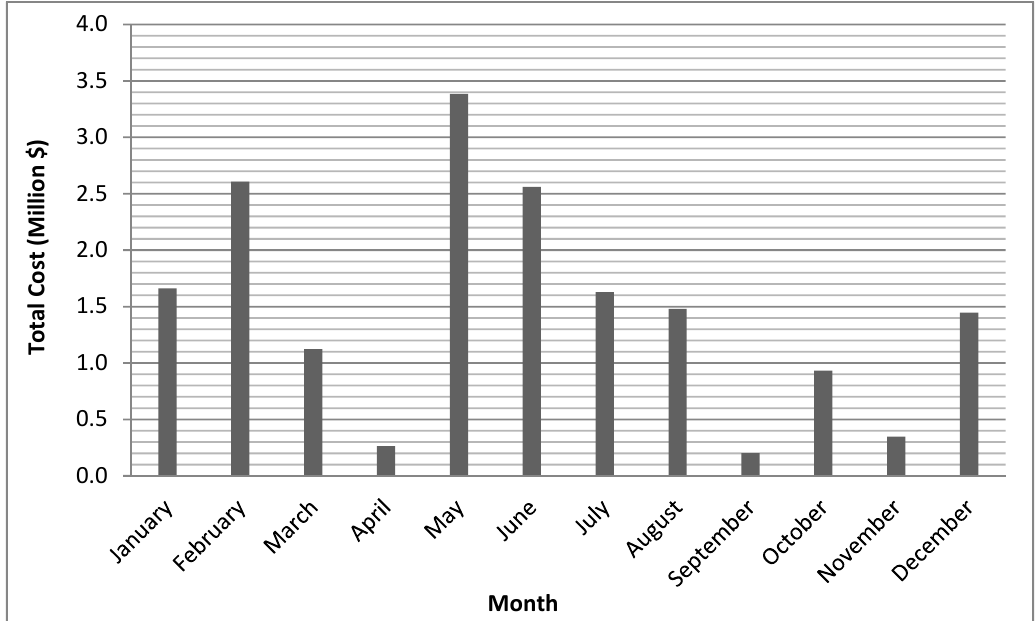
Figure 6. Monthly total procurement cost of woody biomass feedstock for electricity production at the AGS (BASE